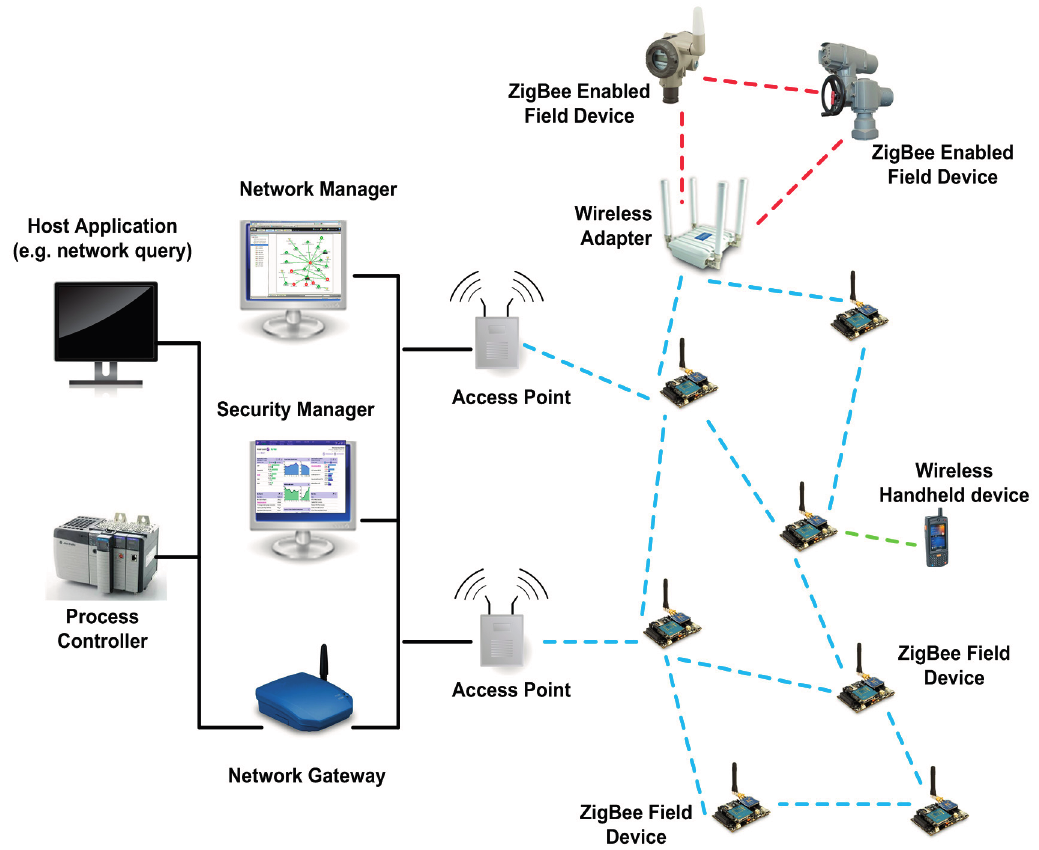
Figure 2. A typical wireless sensor network setup with central